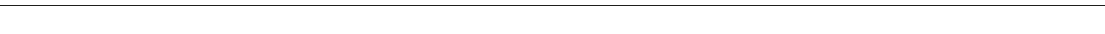
Fig. 3 De novo point mutation of CAMK2G impairs CaM trapping and shuttling by γ CaMKII. a Schematic of γ CaMKII protein, highlighting the putative CaM- trapping region (aa ~286 – 315 within the regulatory region). Amino acids shaded in gray directly bind Ca 2 + /CaM 41,58,63 . Arg292 to Pro292 mutation (R292P, red) identi fi ed as a candidate basis for intellectual disability via family-based exome-sequencing 28 . b L-LTP induction in hippocampal slices from γ CaMKII KO mice (black) or exc-KO mice injected with lentivirus expressing γ CaMKII (blue) or γ CaMKII R292P (red). Note overlap between KO and exc-KO + γ CaMKII R292P traces. Potentiation at 180 min signi fi cantly greater for exc-KO + γ CaMKII (198.9 ± 26.8%), than exc-KO + CaMKII R292P (107.3 ± 5.7%) ( n = 4 mice for each group). Superimposed representative EPSPs show basal EPSP (bold color) and EPSP at 165 min (muted color) after L-LTP induction. Calibration bars, 1 mV and 10 ms. c CaM overlay analysis (Experimental Procedures). Puri fi ed HA-tagged γ CaMKII or γ CaMKII R292P was run on SDS-PAGE gel and membrane exposed to 0.5 μ g/ml CaM for 1 h in the presence of 1 mM CaCl 2 . d Western blot analysis of phospho-Thr287 using antibodies against pCaMKII and HA tag, following incubation of puri fi ed HA-tagged γ CaMKII or γ CaMKII R292P with 25 μ M ATP for 1 min in presence of 1 mM CaCl 2 and 1 μ M CaM. e In vitro phosphorylation of syntide-2 by puri fi ed recombinant HA-tagged γ CaMKII or γ CaMKII R292P was measured using the CycLex CaM kinase II activity ELISA kit. f Dissociation kinetics of phosphorylated γ CaMKII and γ CaMKII R292P. Traces show that dissociation of CaM(C75) IAE from complexes with phospho- γ CaMKII (blue) is 1500-fold faster ( p = 0.002) than from complexes with phospho- γ CaMKII R292P (red). Curves generated by fi tting data to two phase decay ( Y = A 1*exp( − t / τ 1 ) + A 2*exp( − t / τ 2 ) + Y 0 ) 41 . Data normalized so intensity difference between kinase-bound and free Ca 2 + / CaM(C75) IAE would be 1. g – j Western blot probing for nuclear γ CaMKII, CaM, and c-Fos in isolated nuclei of cultured hippocampal and cortical neurons from WT or γ CaMKII KO mice stimulated with 40 mM KCl for 1 h. Both γ CaMKII (WT) and γ CaMKII R292P translocated to the nucleus ( g , h ); however, only re-introduction of transgenic γ CaMKII (WT), not γ CaMKII R292P, into γ CaMKII KO neurons rescued CaM translocation ( g , i ) and c-Fos expression ( g , j ). k c-Fos response in cultured hippocampal and cortical neurons from γ CaMKII KO mice stimulated with 40 mM KCl for 1 h. γ CaMKII (WT) but not γ CaMKII R292P (no HA tag) could restore c-Fos response. Co-expressing γ CaMKII R292P with